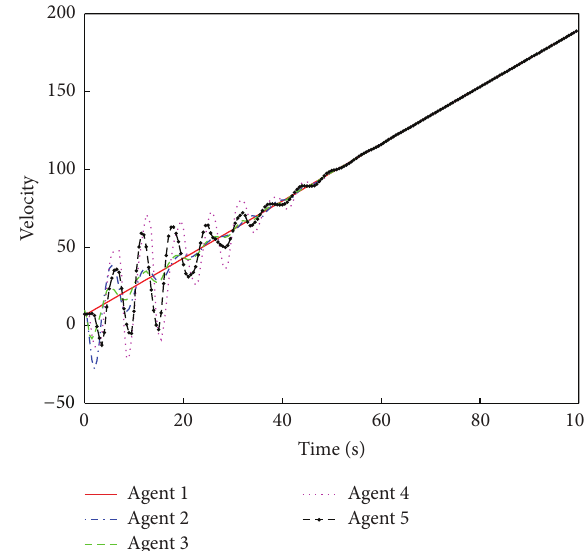
Figure 5: Consensus of velocity for second order system.